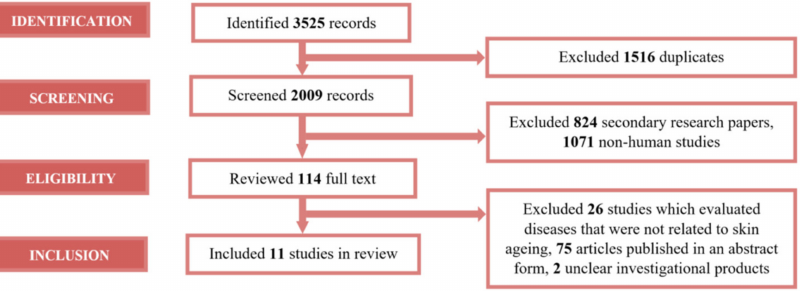
Figure 3. PRISMA flow diagram summarized identified studies during the literature